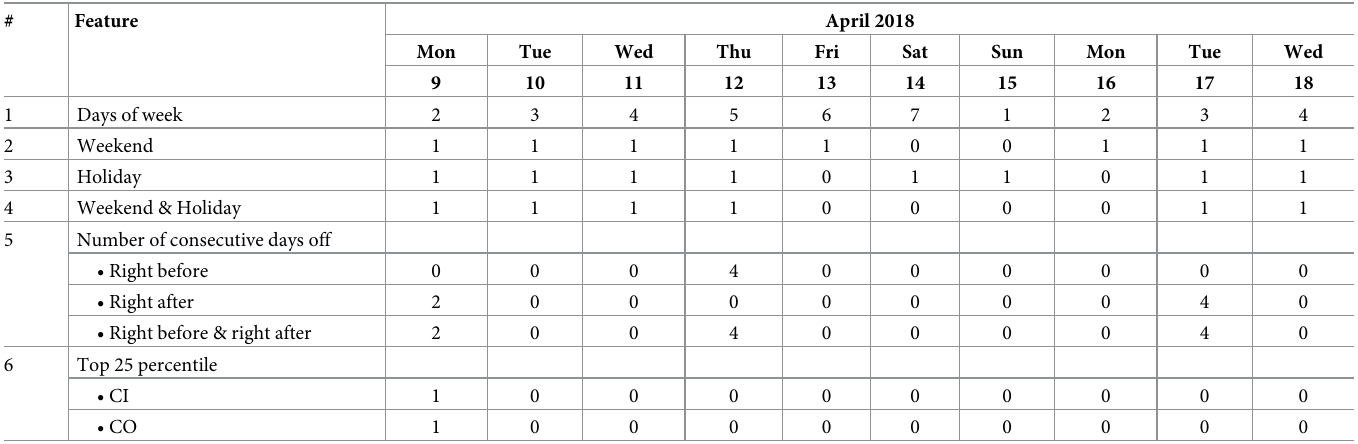
Table 3. Example values of selected features.